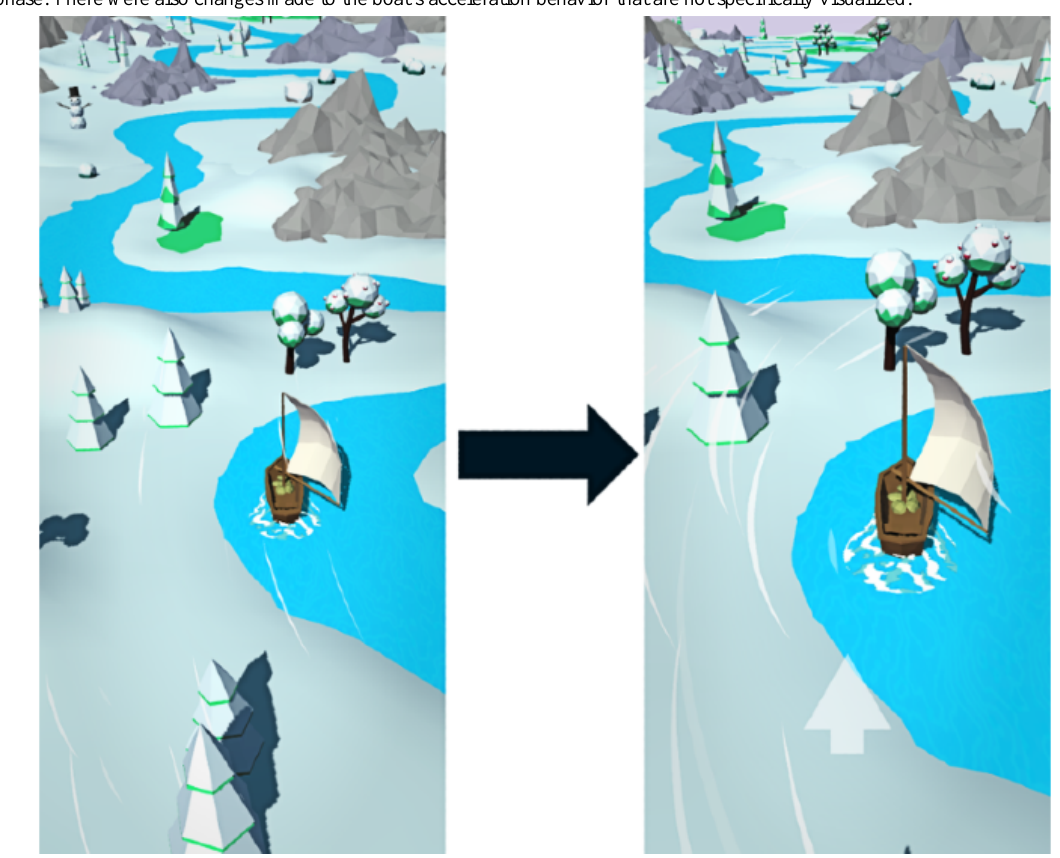
Figure 3. Breeze before (left) and after (right) applying design changes to address problems identified in the pretest. Specifically, the camera was moved closer to the boat, the wind particles were made more pronounced, and an additional user interface element was introduced to indicate the current breathing phase. There were also changes made to the boat’s acceleration behavior that are not specifically